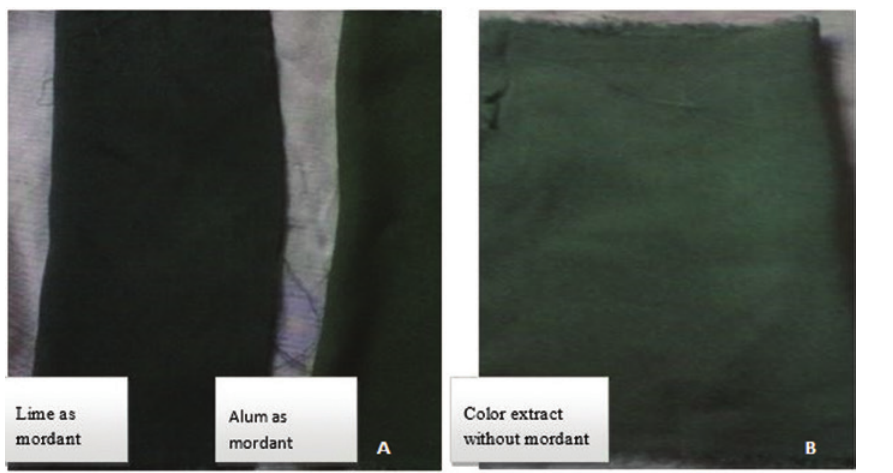
Figure 9: Application of color extracted from Atriplex rubra and Spinacea oleracea . (A) Change in colour when applied Lime and Alum as mordant (B) Colour effect without